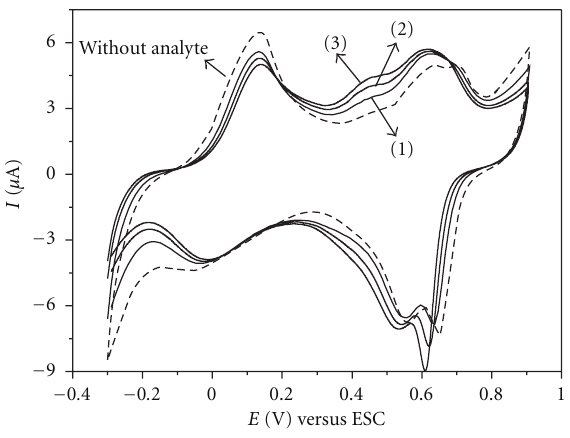
Figure 7: Cyclic voltammograms for LbL films from (PANI-AP/ GC) 6 film in the absence and presence of 0.01mmolL − 1 DA containing ascorbic acid at a concentration of (1) 0.01 mmol L − 1 (2) 0.02mmol L − 1 and (3) 0.03 mmol L − 1 in 0.1 molL − 1 HCl solution, at 50mVs − 1